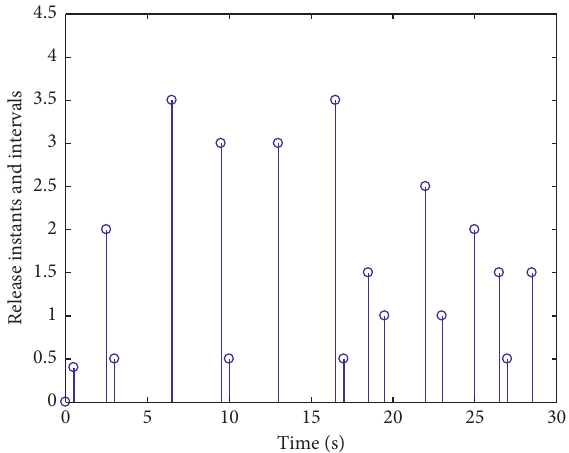
Figure 11: The “event-triggered” of “hybrid-driven” release in- stants and interval in Case